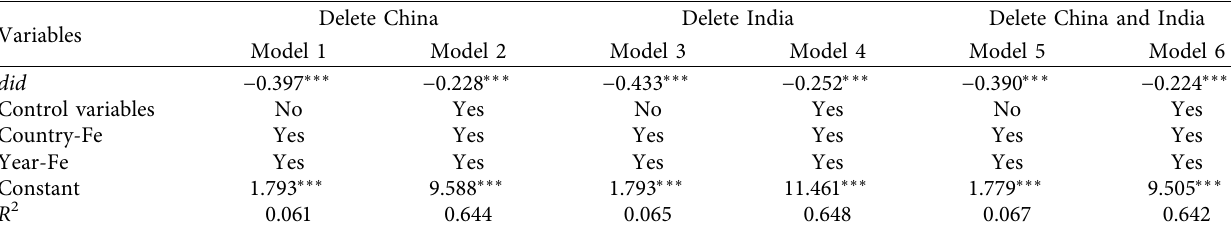
Table 5: Test results of deleting China and India samples.